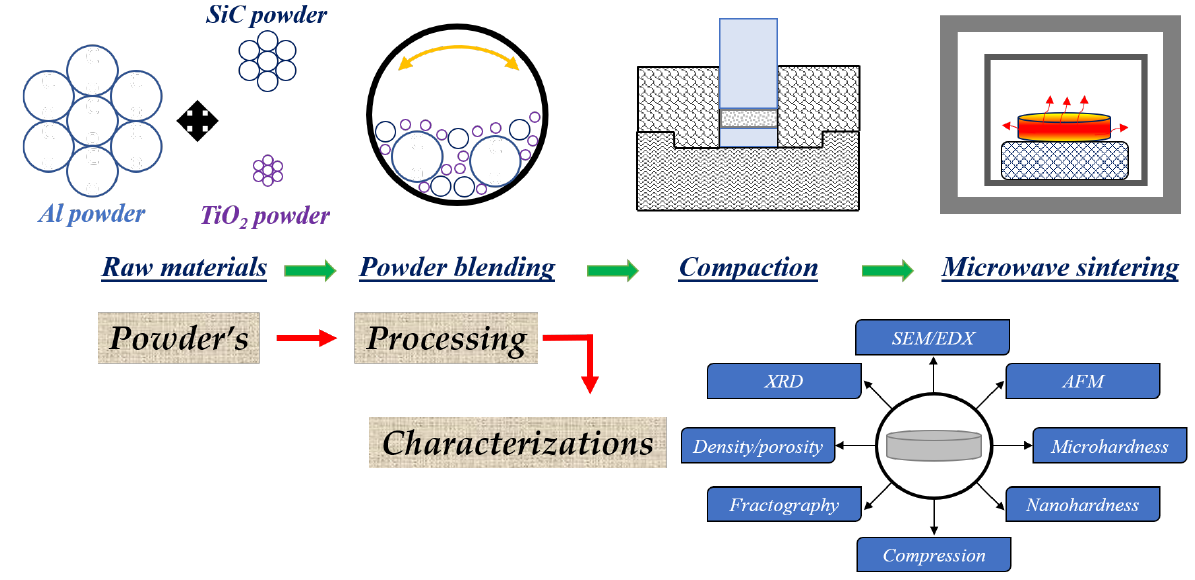
Figure 1. Schematic diagram of the developed Al/SiC/TiO 2 hybrid nanocomposites.